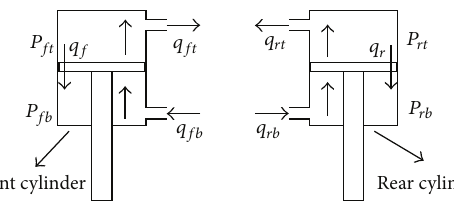
Figure 3: Mechanical-fluid system boundary